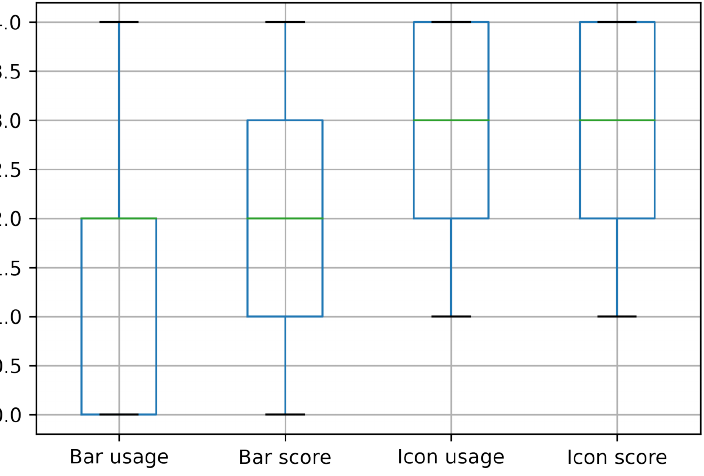
Figure 8. Evaluation of bars and icons in terms of usage ( p = 0.004) and score ( p =